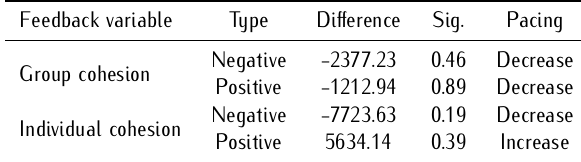
Table 12. Differences in pacing after feedback exposure.